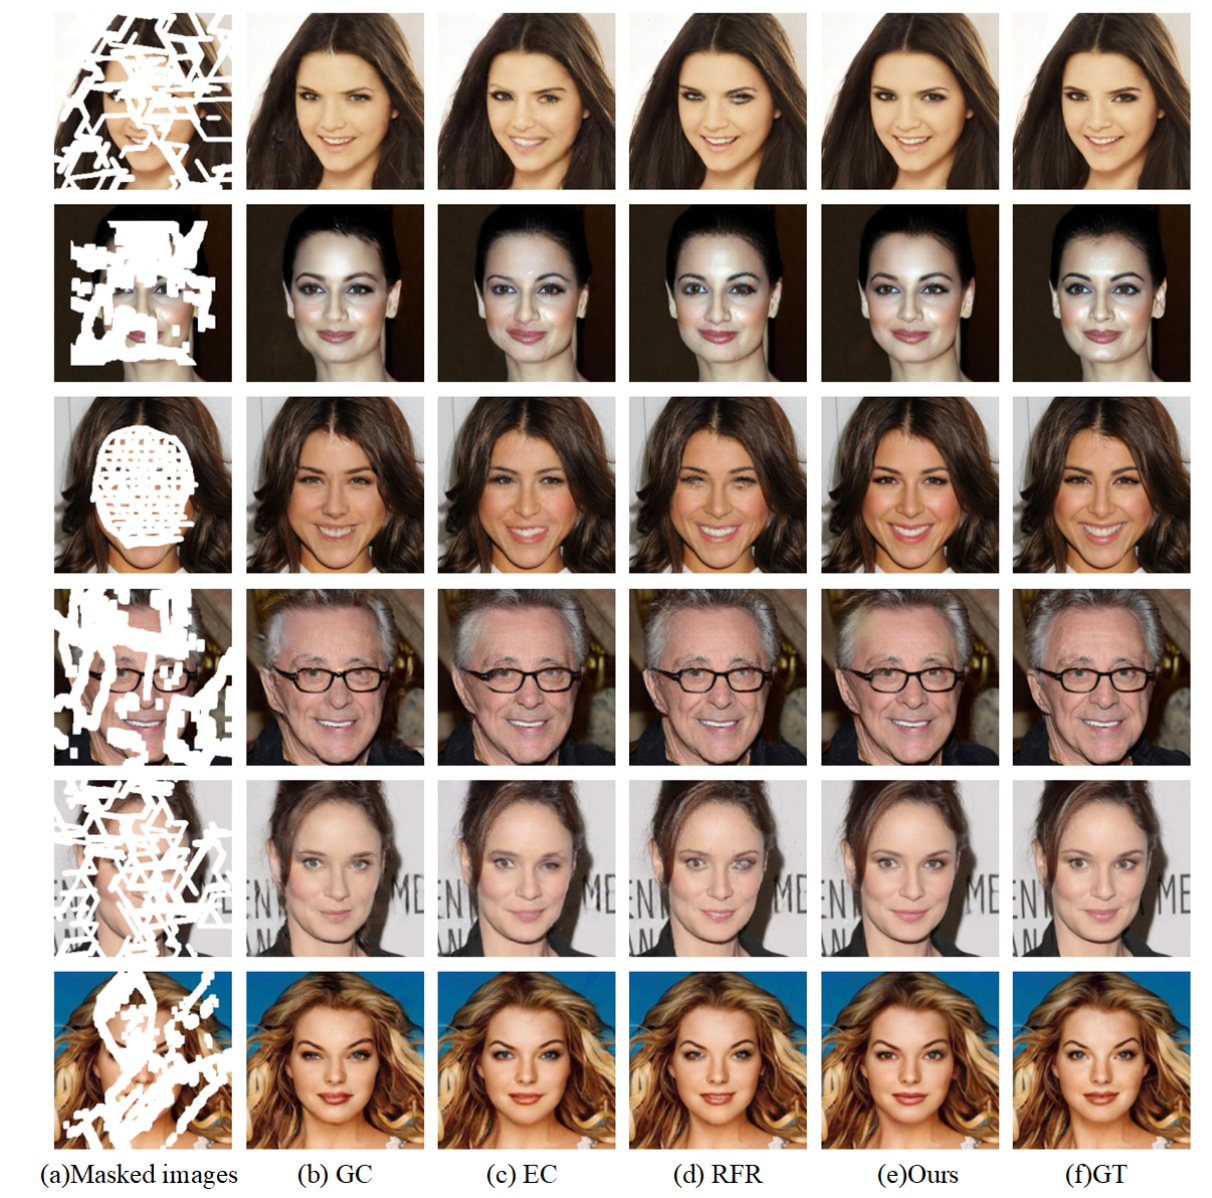
Figure 3. Qualitative comparison results under free-form